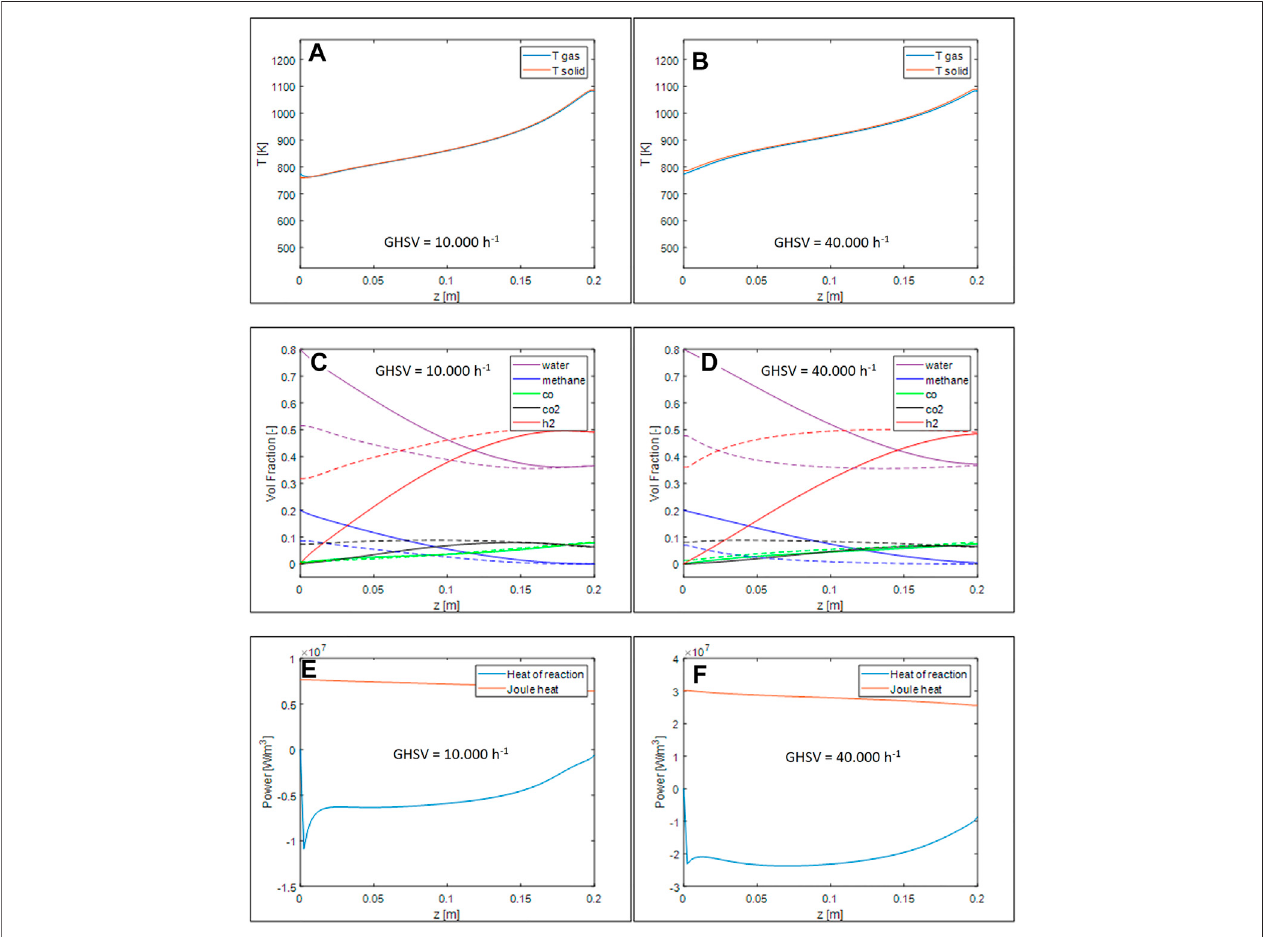
FIGURE7| Axialtemperaturepro fi lesforGHSV (cid:2) 10.000h − 1 (A) and40.000h − 1 (B) ,volumetricfractionaxialpro fi leforGHSV (cid:2) 10.000h − 1 (C) and40.000h − 1 (D) , thermal power generated and required by the reaction for GHSV (cid:2) 10.000 h − 1 (E) and 40.000 h − 1 (F) .